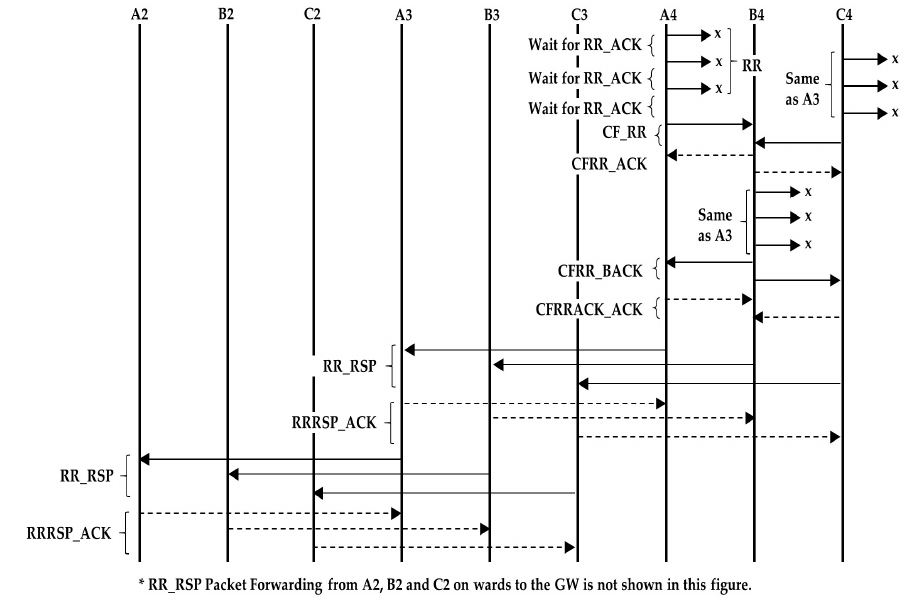
Figure 6. Propagation of the RR_RSP message.